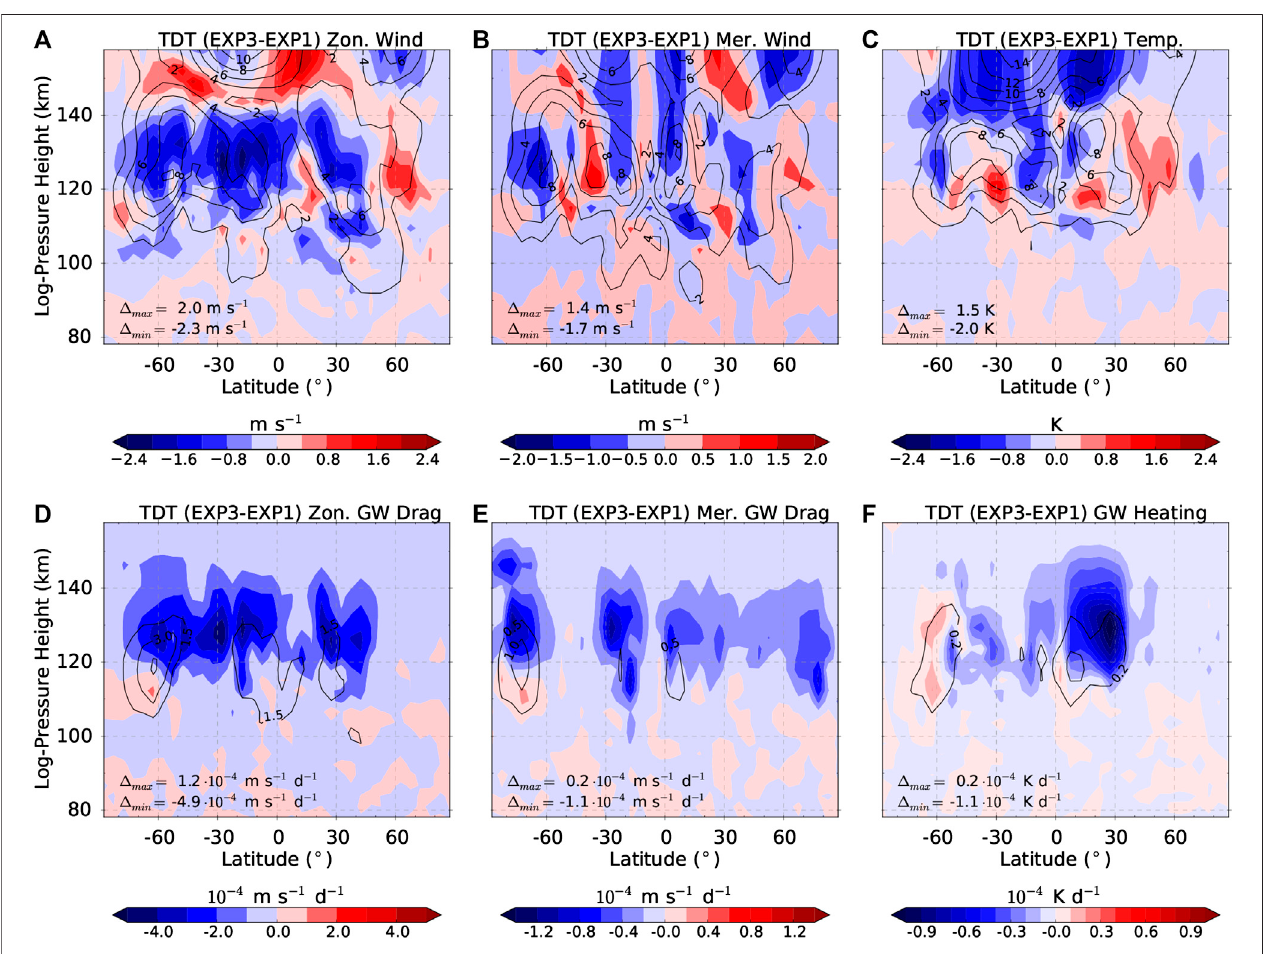
FIGURE 11 | Same as Figure 10 but for EXP3 (contour lines) and differences EXP3-EXP1 (color shading).